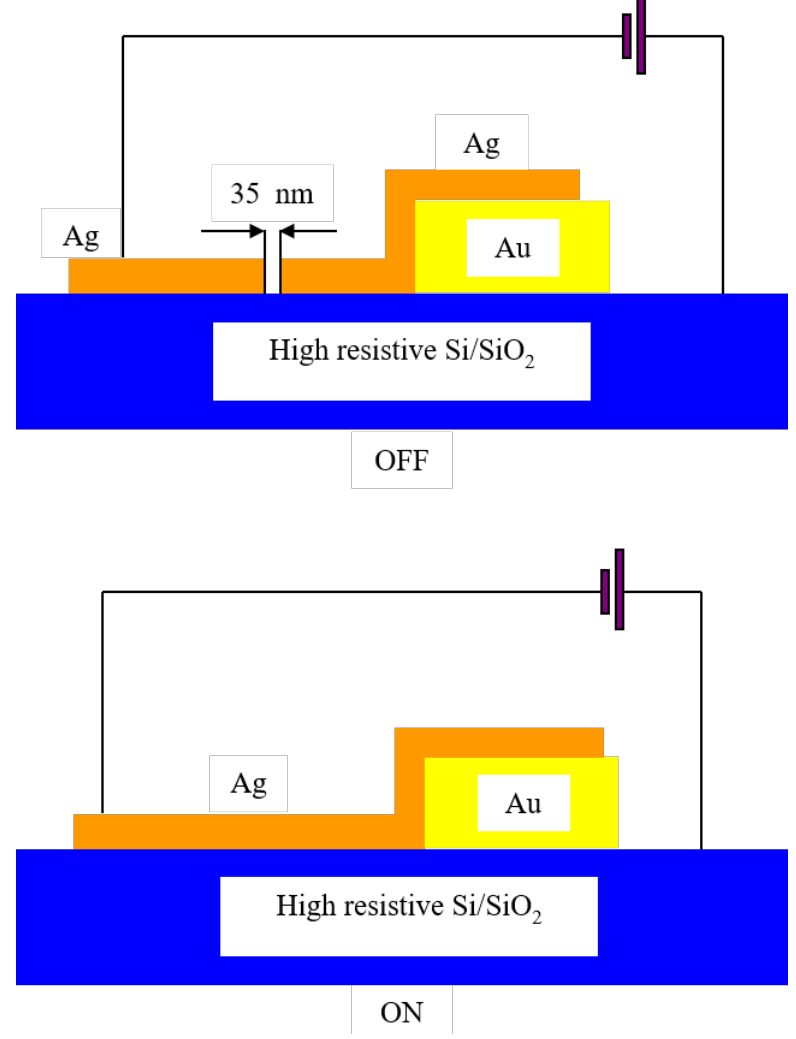
Figure 4. Schematic representation of the nano-ionic memristor microwave switch and its states.